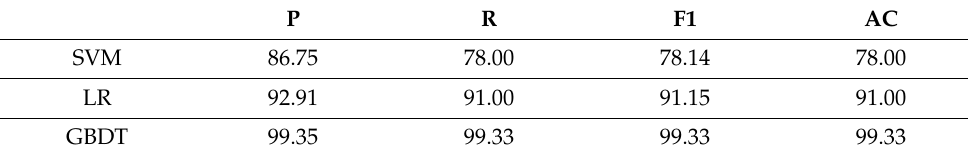
Table 3. Performance comparison using different algorithms on S 21 .